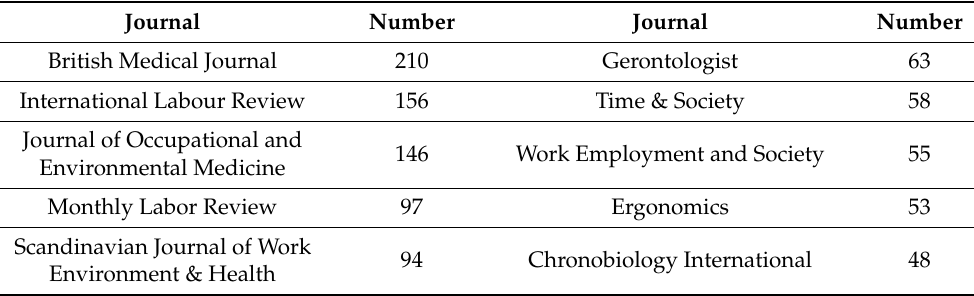
Table 1. Top 10 journals that have published at least ten research articles.